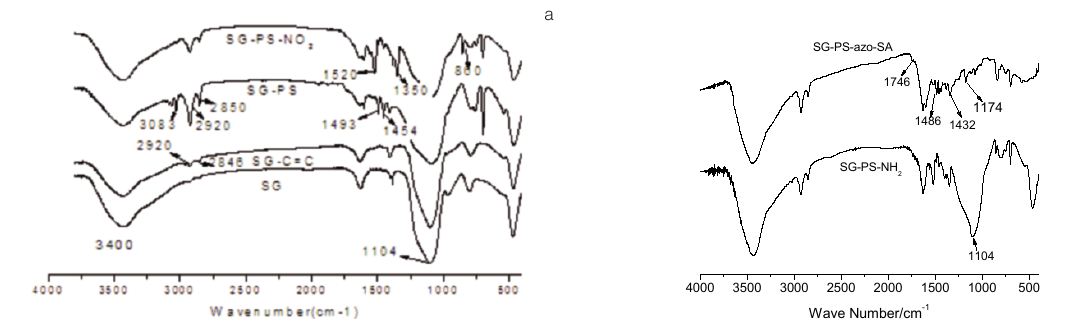
Figure 1. FT-IR spectra of the intermediates and the composite SG-PS-azo-SA (a: SG, SG-C=C, SG-PS, SG-PS-NO